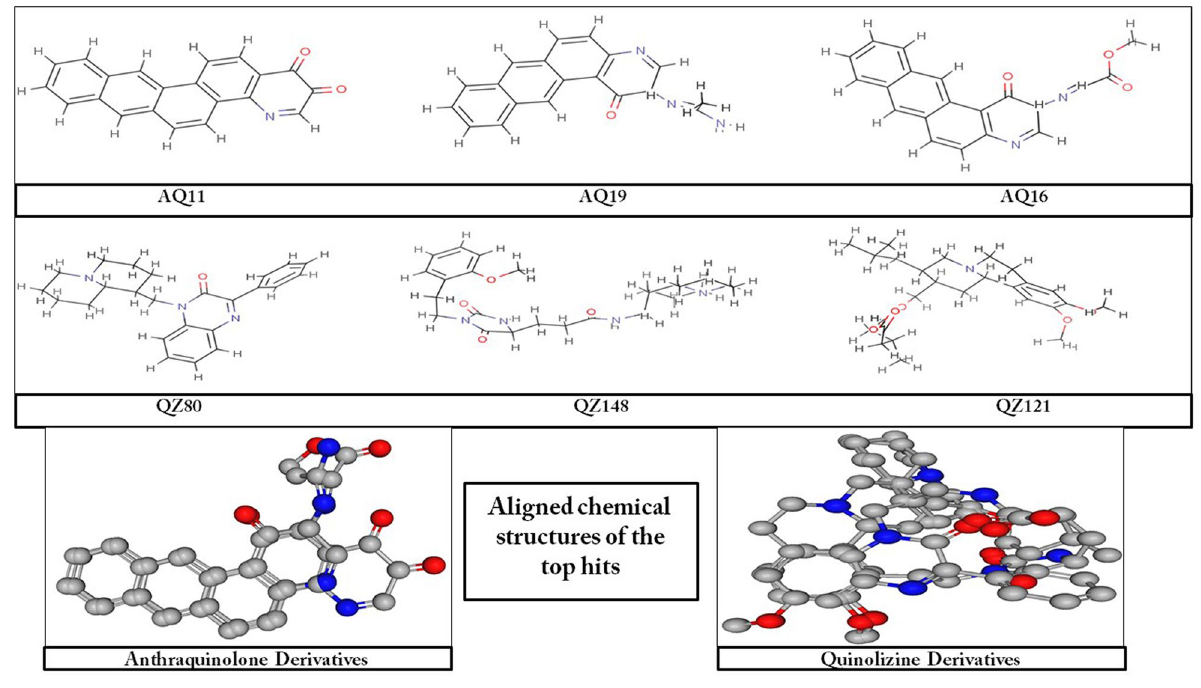
Figure 4. Chemical structures of selected top hits of AQ and QZ.